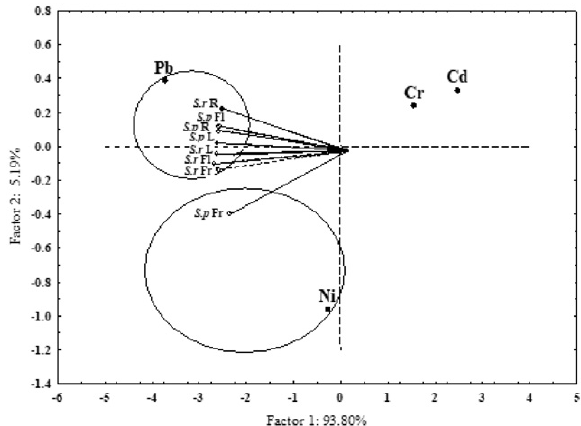
Figure 6. PCA Diagram of heavy metal content (Cd, Cr, Ni, and Pb) content variables in leaf, flower, fruit, and root of plant species S. rigidum and S. pallasii